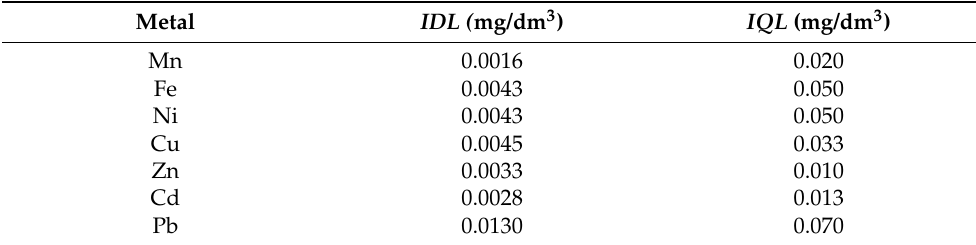
Table 2. The instrumental detection limits ( IDL ) and instrumental quantification limits ( IQL ) for the spectrometer iCE 3500 (mg/dm 3 ) [52,53].